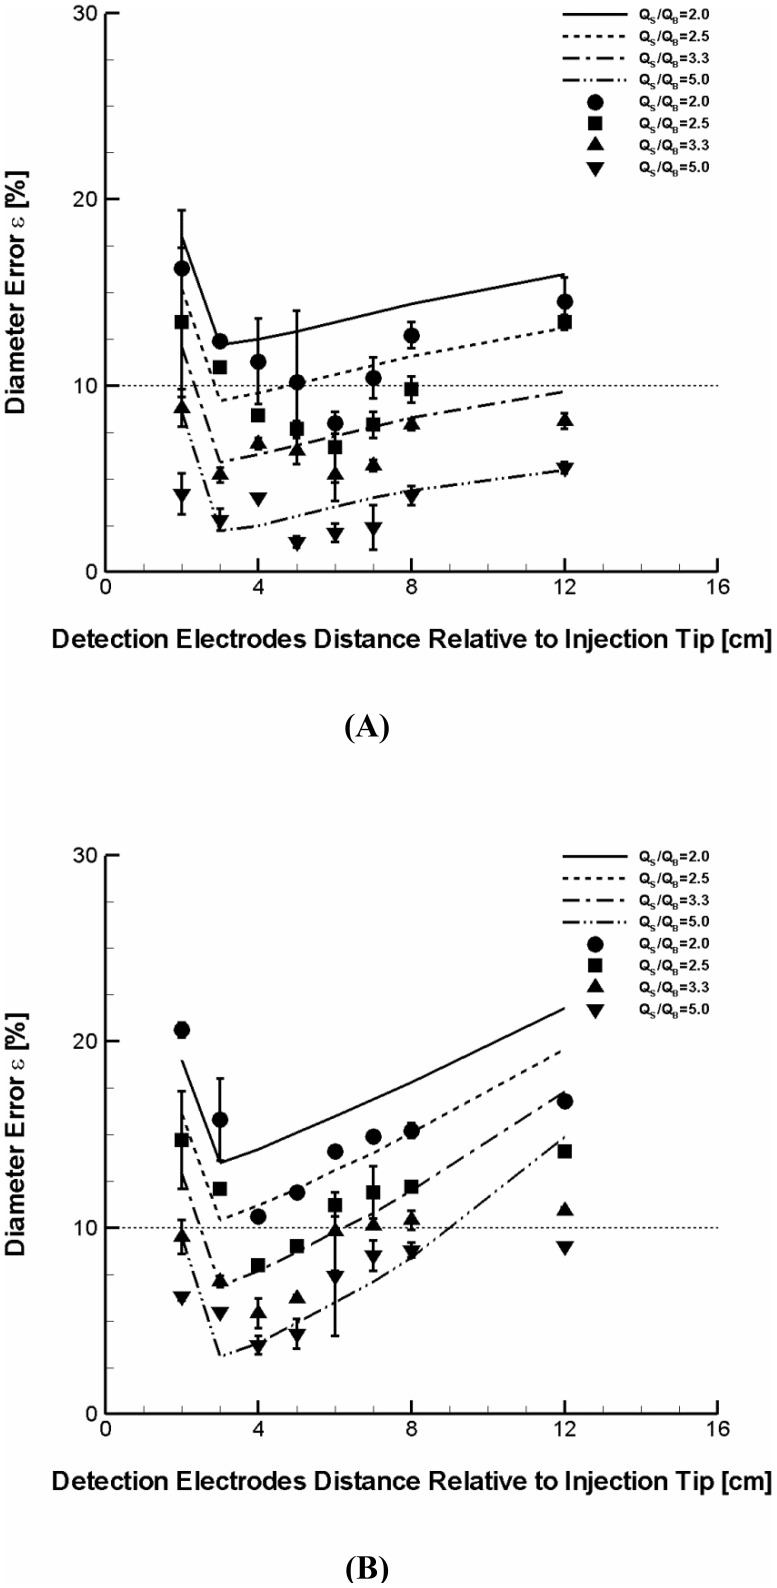
Comparison of the percent error in diameter calculated by simulations and conductance measurements of phantoms at four different ratios of injection rate to baseline flow rate (i.e.,  = 2, 2.5, 3.3, and 5) for two different sizes (A) DL = 7 mm and (B) DL = 10 mm.Lines and symbols represent simulations and measurements, respectively. Circle and solid, rectangle and dashed, triangle and dashed-dot, and gradient and dashed dot-dot denote the flow rate ratio of 2, 2.5, 3.3, and 5, respectively. Half normal saline was used as a baseline flow medium. Each conductance measurement was made in three (n = 3) phantoms for each diameter. The largest error was found to be 4 and 3.2% for 7 and 10 mm diameter phantom, respectively.